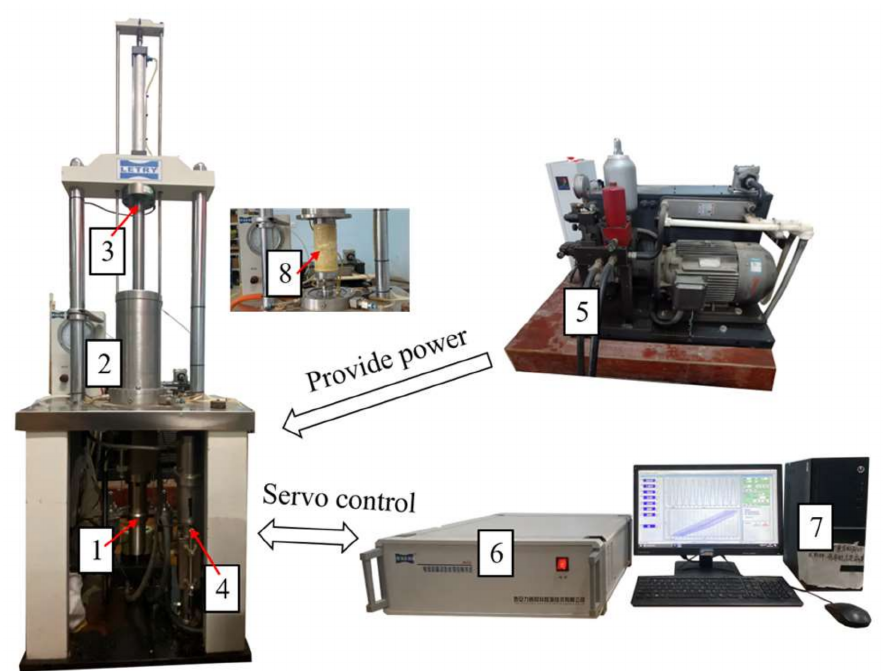
Figure 6. The laboratory triaxial apparatus for monotonic and repeated-loading tests. 1. Vertical loading system, including a hydraulic servo actuator and transducer for axial deformation; 2. triaxial cell (specimens); 3. transducer for axial force; 4. confining pressure servo; 5. oil pressure system, including a high-pressure syringe pump; 6. controller; 7. computer interface system; and 8.